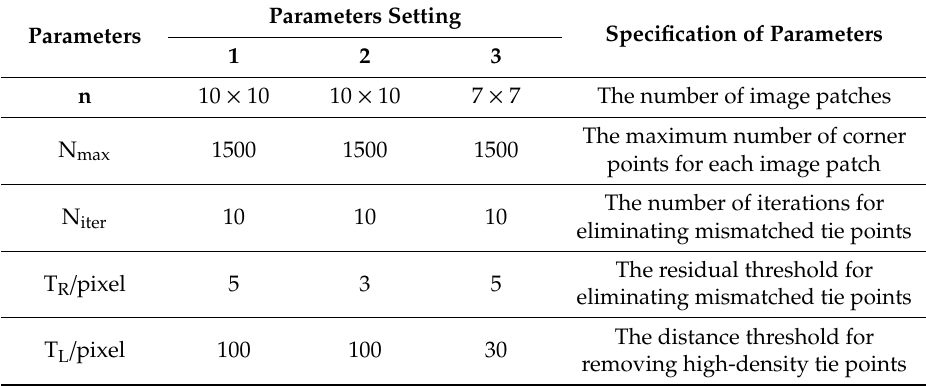
Table 3. Parameter settings for the three sets of experimental